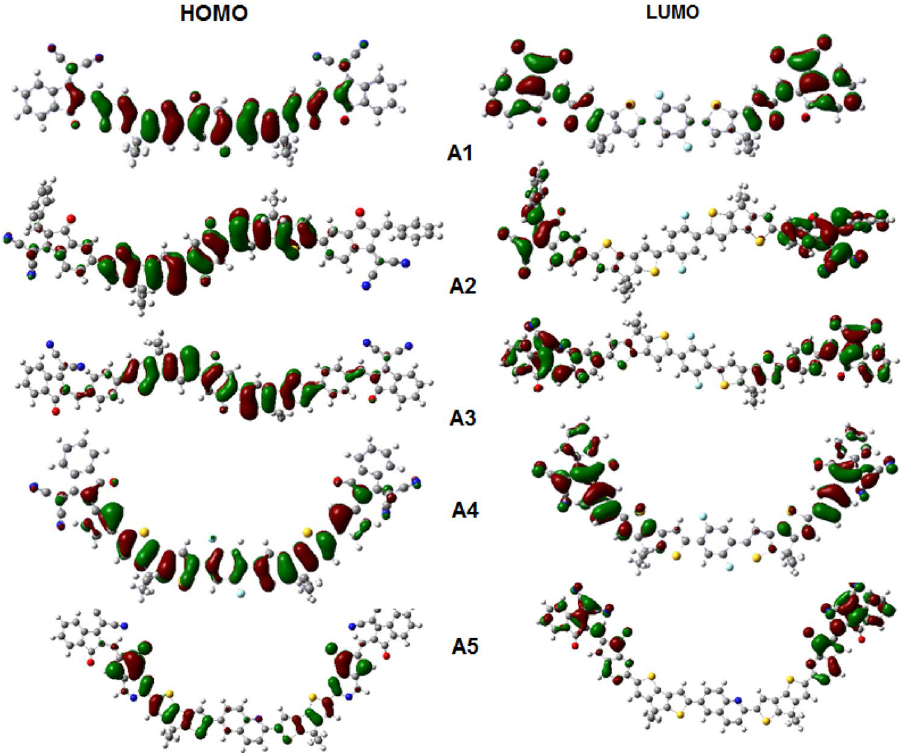
Figure 2. Distribution of HOMO and LUMO of the molecules A1 – A5 at B3LYP 6-31 G